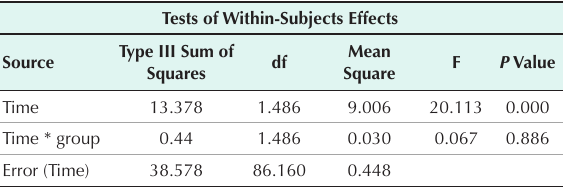
Table 3. The Results of ANOVA With Repeated-Measures of the Severity of Diaper Dermatitis in the Intervention Group